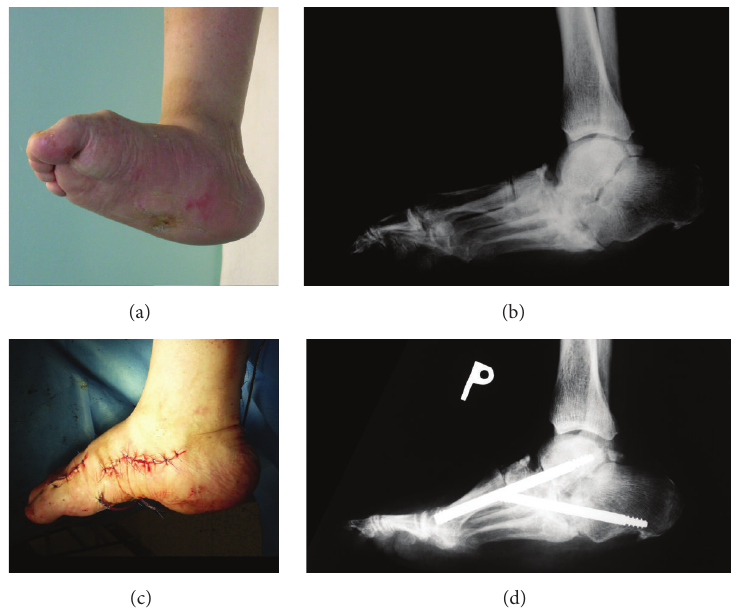
Figure5:(a)ClinicalimageofCNwithcollapsedmiddlepartoftarsusandplantarsinus(rightfoot).(b)PreoperativeX-rayimageofcollapsed arch in the middle part of tarsus. (c) Clinical image immediately after reconstruction with reconstructed longitudinal arch. (d) Lateral X-ray image demonstrates reconstruction of both columns two months after